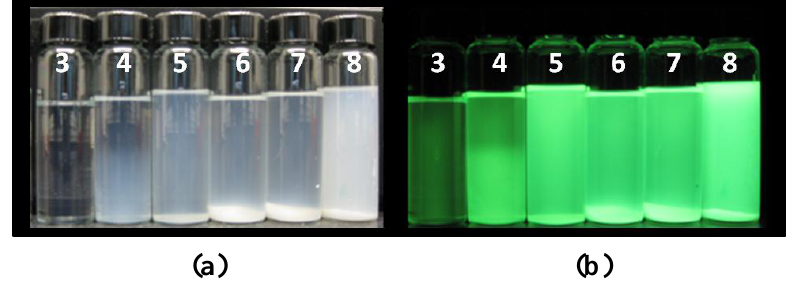
Figure 8. Zeta potential of ASA:Tb 3+ :LaF